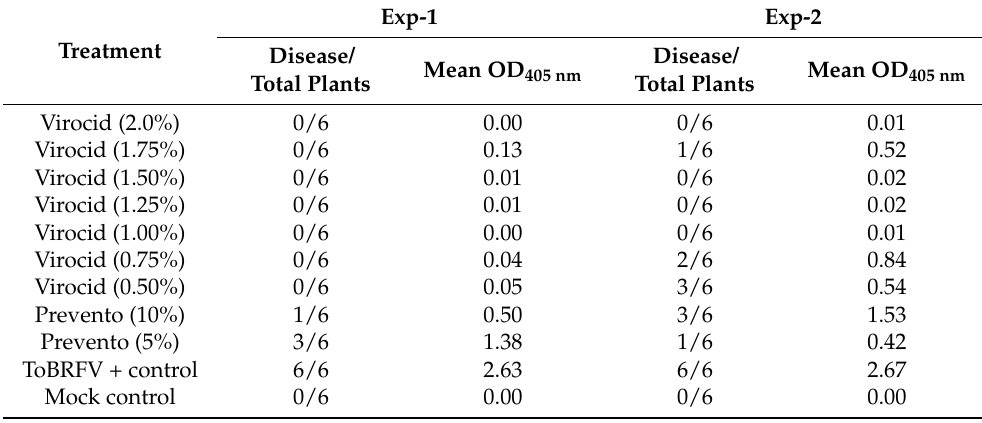
Table 2. Bioassay to assess the efficacy of Virocid and Prevento at serial dilutions for short exposure time to treat ToBRFV